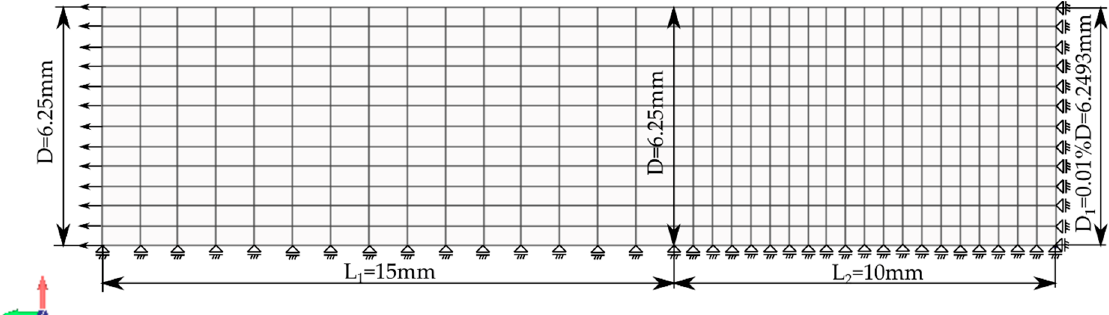
Figure 11. Finite element mesh, imperfection, loading, and boundary conditions.